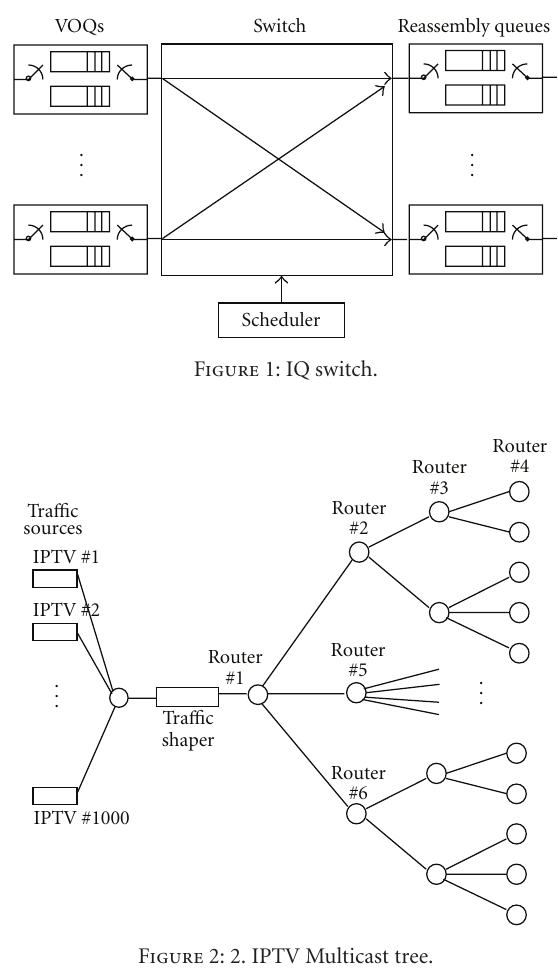
Figure 2: 2. IPTV Multicast